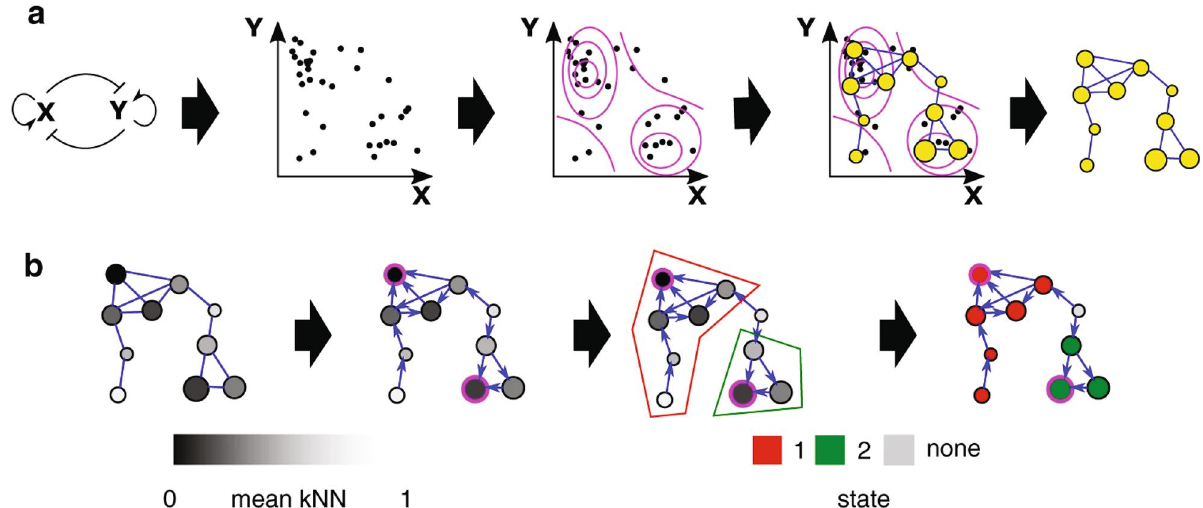
Figure 1. Microbial communities as metastable dynamical systems. This illustration of the Mapper algorithm is adopted without modifications from 25 and is licensed under CC BY 4.0. ( a ) A community with two species X and Y, that inhibit each other’s growth. The interactions between species make some community compositions more likely than others: either one species is very abundant at the cost of the other, or vice versa. If those configurations are equilibrium states and stable against small perturbations (i.e., if they attract all configurations in their vicinity), they can be considered attractors. The mapper plot can be used to find attractors: It groups samples into clusters (yellow dots) according to their similarity. Clusters with similar compositions are plotted close to each other. The same data-point (a sampled community) can belong to more than one cluster. Then, it connects the clusters that share communities (samples) making a network. Because clusters have different numbers of samples, those with the highest local number of samples potentially are attractors. ( b ) Finding the attractors in the mapper network. Each node is assigned a k-nearest neighbours (kNN) value (inversely proportional to the density of points) that is later modified to get a potential. The arrows are then directed from higher to lower potential. The nodes with the lowest potentials correspond to attractors, and the nodes that lead to them form their corresponding basin of attraction (all the community states that eventually converge to the attractor). The outcome shows two attractors that correspond to either X or Y with high abundance and the other excluded.